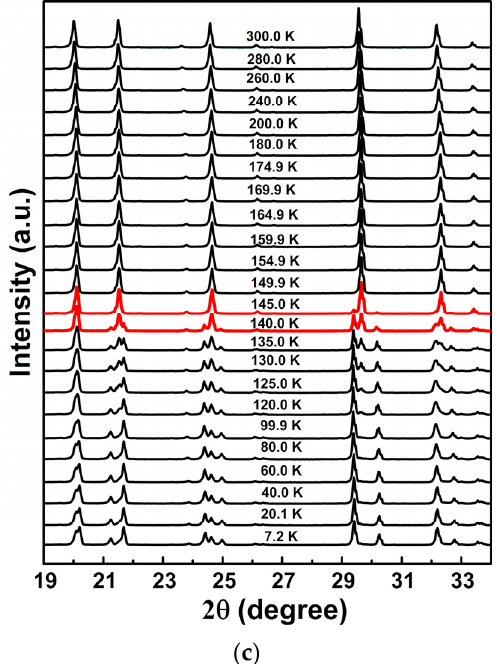
Figure 4. Powder XRD patterns of [(CH 3 ) 2 NH 2 ][Fe(HCOO) 3 ] between 10 K and 300 K, with diffraction angle 2 θ in the range of ( a ) 10–70°, ( b ) 14–15.5°, ( c ) 19–34°.